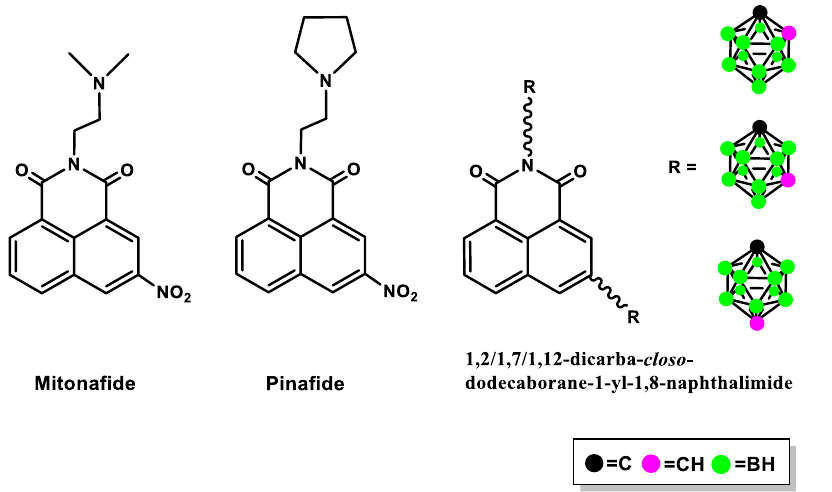
Figure 1. Structures of mitonafide, pinafide, and 1,8-naphthalimides modified with a carborane cluster [8,9].